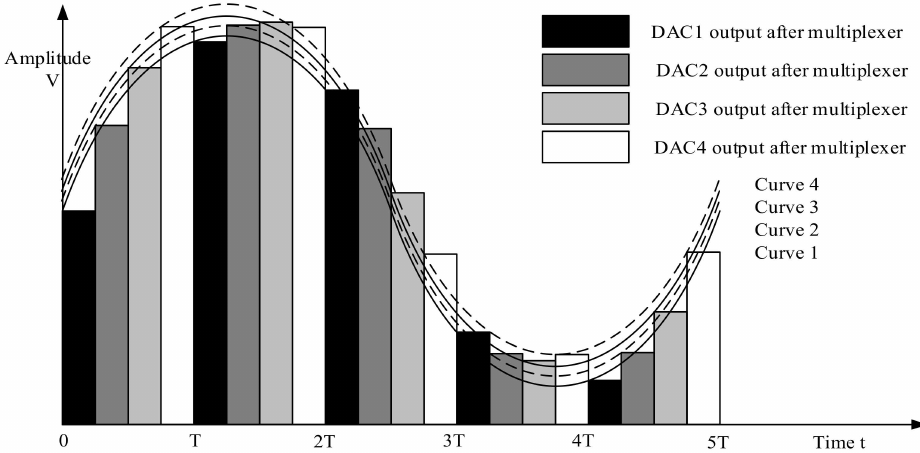
Figure 7. Multiplexer output waveform when the amplitude is not